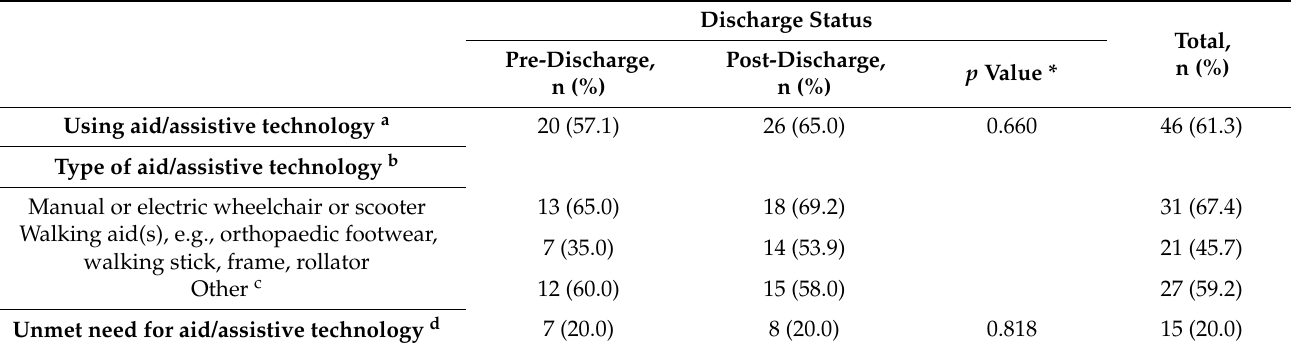
Table 3. Use of and unmet need for aids and assistive technology.